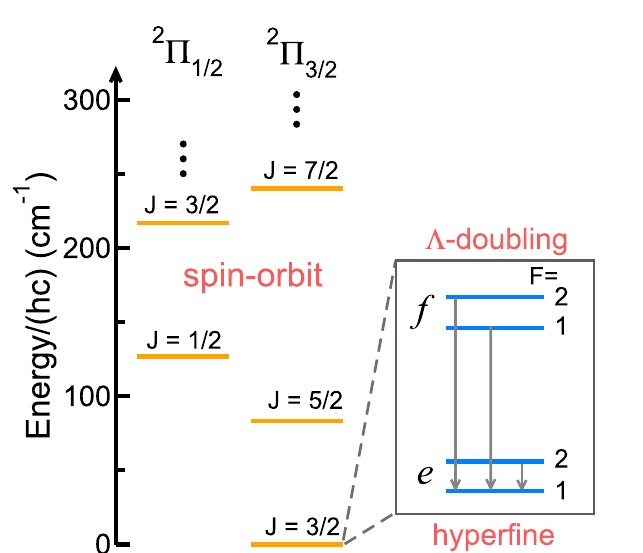
0 vibrational level of the X 2 (cid:31) (cid:30) state of 16 O 1 H . The left-hand side of the figure Figure 5. Energies of the v = 1 / 2 and 3/2 spin-orbit splitting as well as a rotational progression in J . A blowup of the less than shows the � = 1 (cid:31) -doubling (labeled by e and f ) and hyperfine splittings ( F 0.1cm hc − × 3 / 2 level are shown on the right. Hyperfine splittings are due to coupling between the nuclear spin and J = electronic motion. Arrows indicate the relevant collision-induced transitions between hyperfine components within 16 O 1 H . Their transition energies are given in the text. The zero of energy is at the energetically-lowest hyperfine